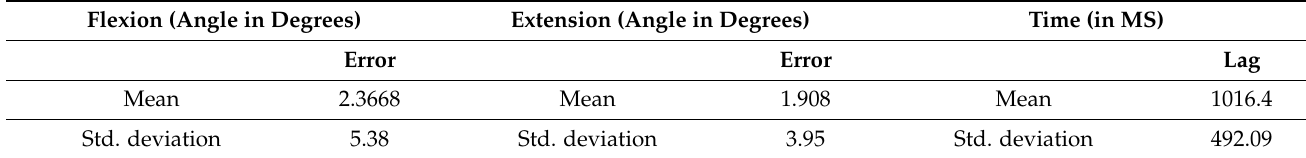
Table 2. Mean errors with time lag.